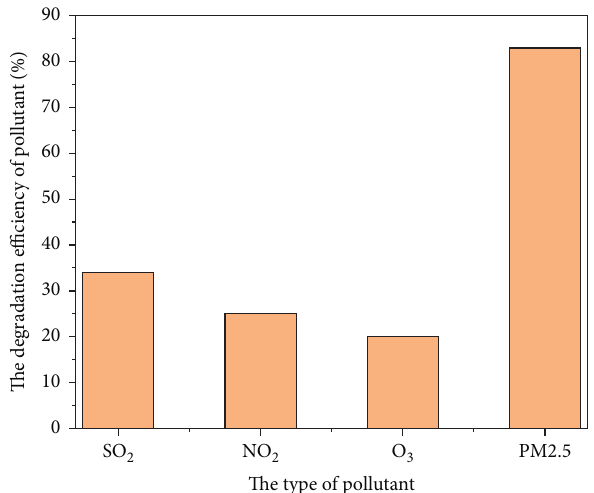
Figure 8: Degradation efficiency of TiO